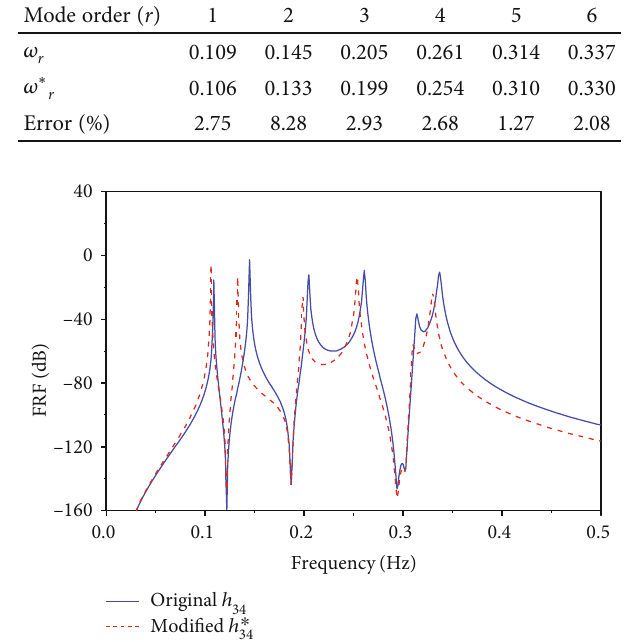
Figure 4: Comparison of exact and modi fi ed FRF h modi fi